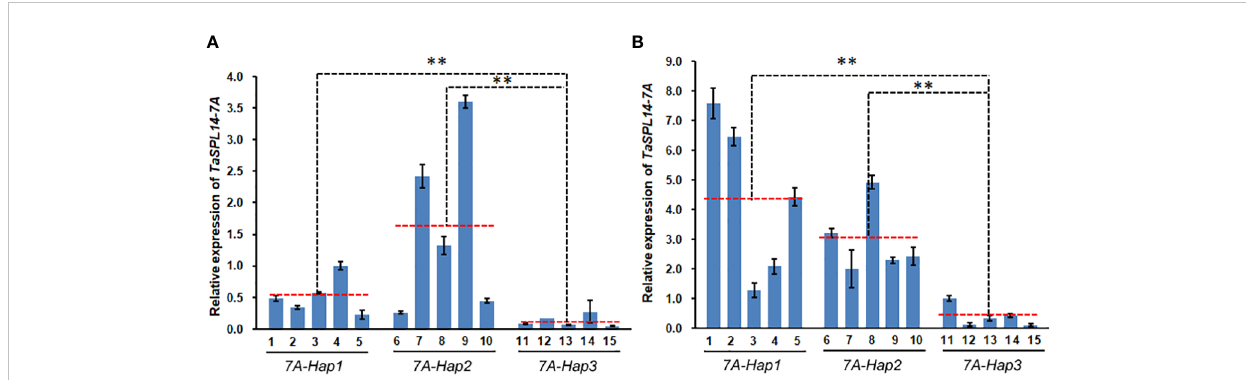
FIGURE 6 Differential expression of TaSPL14-7A in different haplotypes. (A) TaSPL14-7A expression was compared in the 1 cm young spikes. (B) TaSPL14-7A expression was compared in the stems at elongation stage. The red-dashed lines indicate the average expression levels of each haplotype